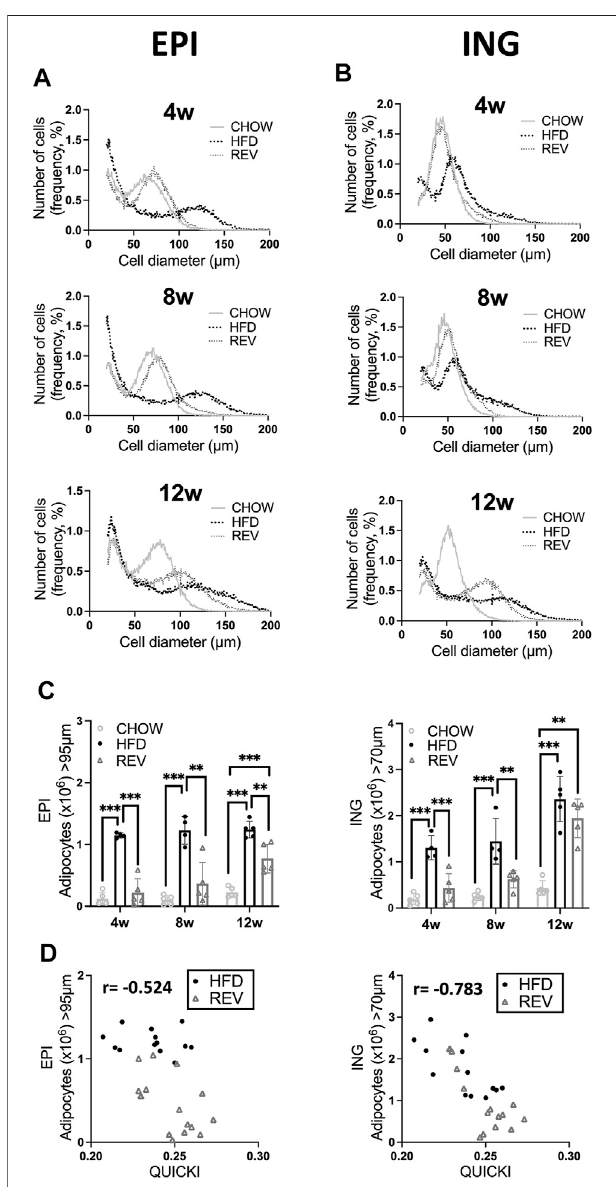
FIGURE 4 | Time resolved analysis of cell-size distribution from epididymal and inguinal adipose tissue. Mice were subjected to diet interventionfor4,8or12 weeks,eachtimepointcontainingthefollowingthree groups: CHOW, HFD and REV (see Figure 1 for study outline). Adipocytecell-sizedistribution of (A) EPI and (B) ING fatdepot, obtainedfrom Coulter counter analysis, displaying CHOW, HFD and REV groups from 4 weeks (top panel), 8 weeks (middle panel) and 12 weeks (bottom panel). Cell-size distribution graphs display the percentage of cells (y-axis) and cell diameter (µm) (x-axis), n = 4 – 5/condition and time point. (C) Total number of hypertrophicadipocytes(EPI > 95 μ m,ING > 70 μ m,de fi nitionandcalculation seemethod Section2.8 )inEPI(left)andING(right)adiposetissue. (D) Scatter plot displaying correlation between number of hypertrophic adipocytes (de fi ned as above) and insulin sensitivity (QUICKI) in EPI (left panel) and ING (right panel) fat depot, with corresponding r value from Pearson correlation. Data are displayed as mean ± SD. One-way ANOVA, Tukey ’ s post-hoc test, was used as statistical analysis of differences between CHOW, HFD and REV for each time point (4, 8, and 12w). Signi fi cance was determined according to * p ≤ 0.05, ** p ≤ 0.01 and *** p ≤ 0.001.